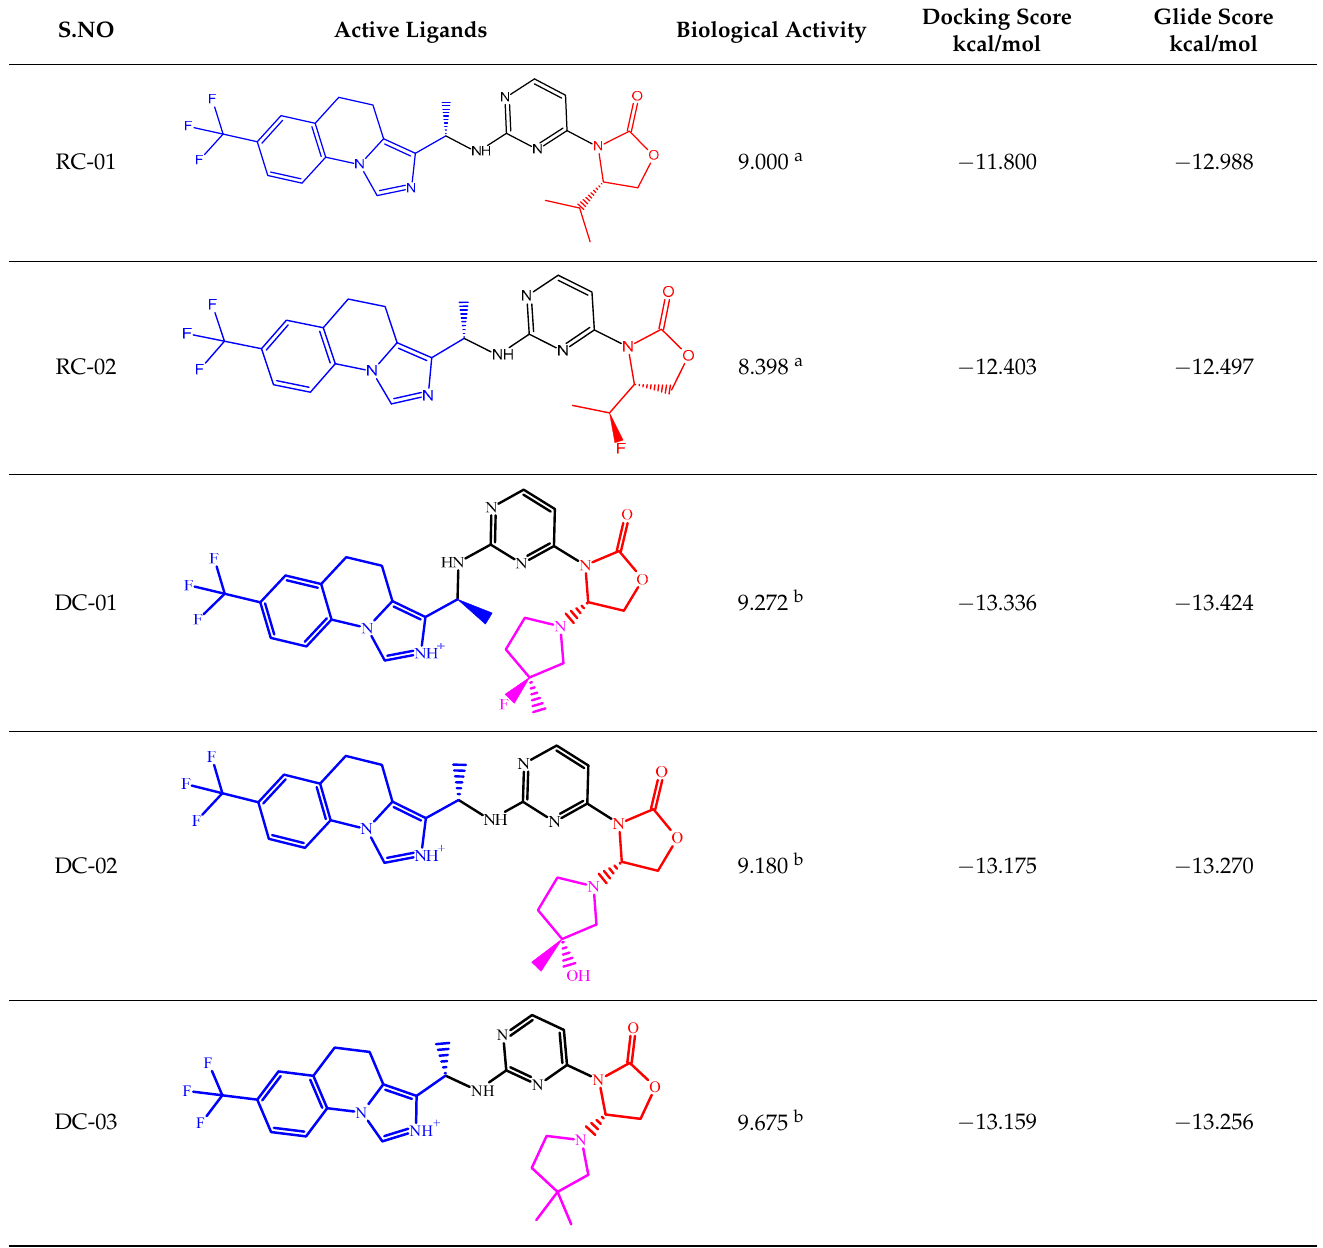
Table 2. The selected designed and reference compounds along with their biological activity and docking scores.